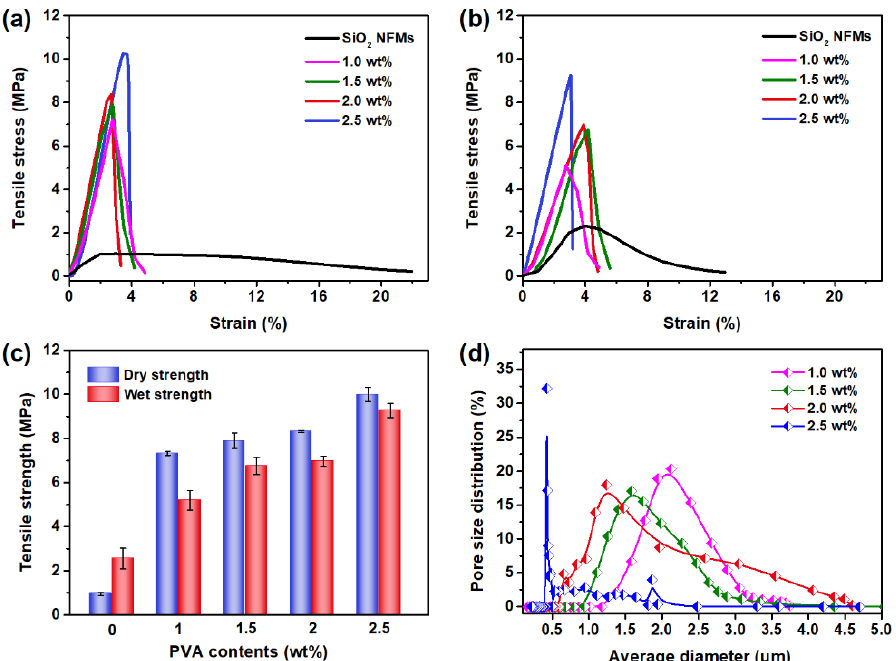
Figure 5. Stress–strain curves of the SiO 2 NFMs and relevant NHMs in ( a ) dry and ( b ) wet states. ( c ) The corresponding strength and ( d ) pore size distribution of these samples.